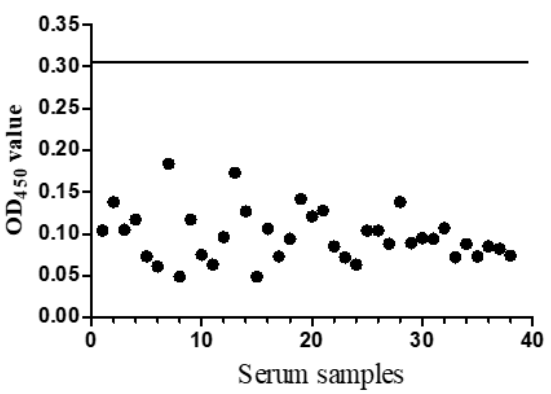
Figure 3. Evaluation of the cut-off OD 450 value of the indirect ELISA. The black solid line presents the OD 450 cut-off value (0.304).